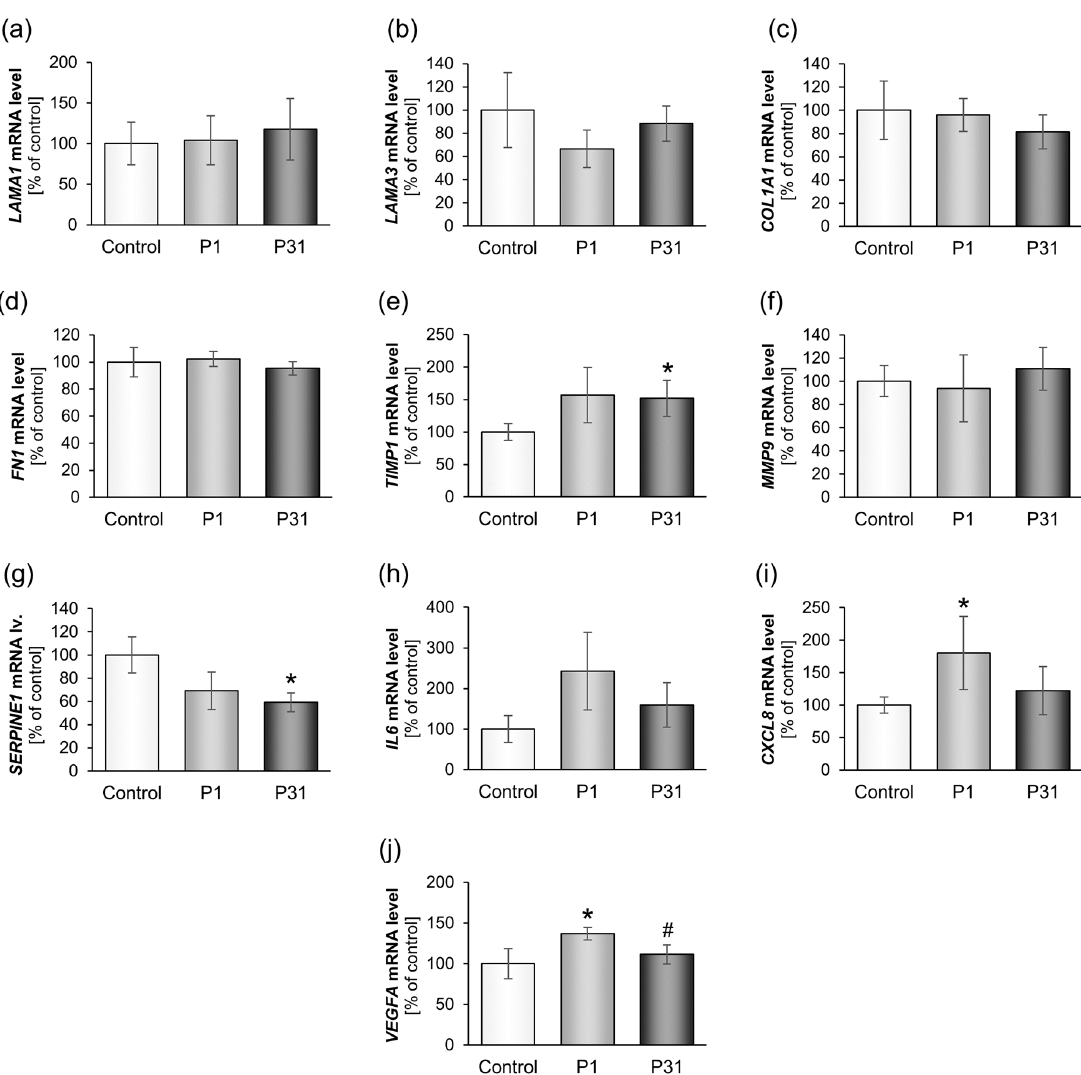
Figure 7. Influence of short-term microgravity on expression of different ECM and cytokine genes. * p < 0.05 vs. Control; # p < 0.05 vs. P1.